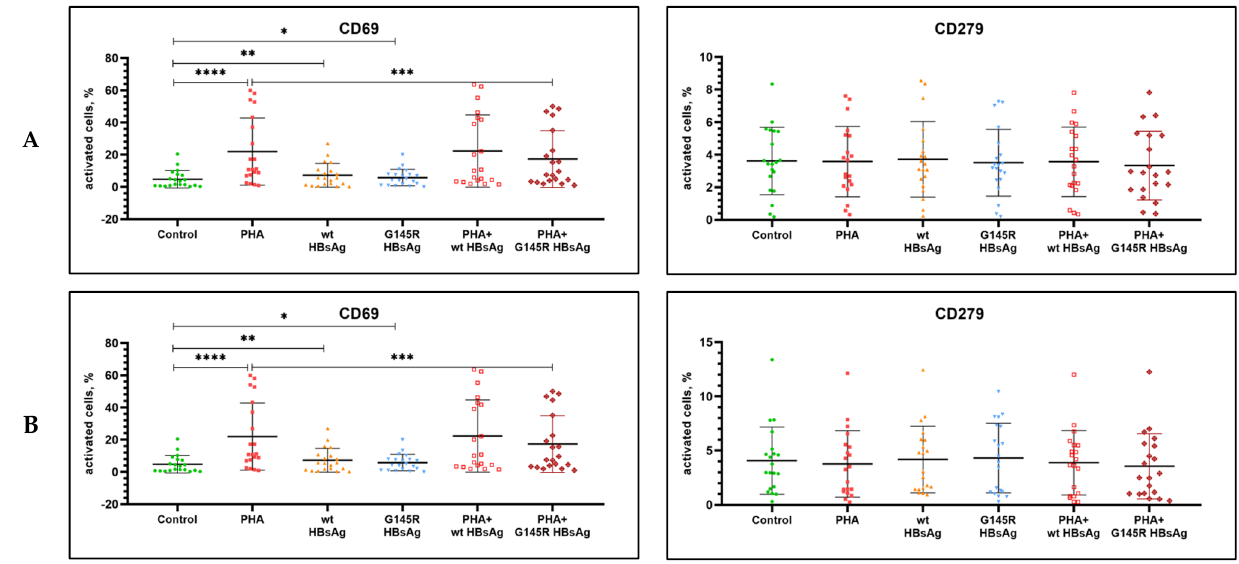
Figure 3. Assessment of surface markers on T cells stimulated with wild-type rHBsAg, the rHBsAg G145R mutant, or PHA, or their combinations. ( A )—CD4 + T cells, ( B )—CD8 + T cells. Significant p values are reported as asterisks, where * p ≤ 0.05, ** p ≤ 0.01, *** p ≤ 0.001, and **** p ≤ 0.0001.